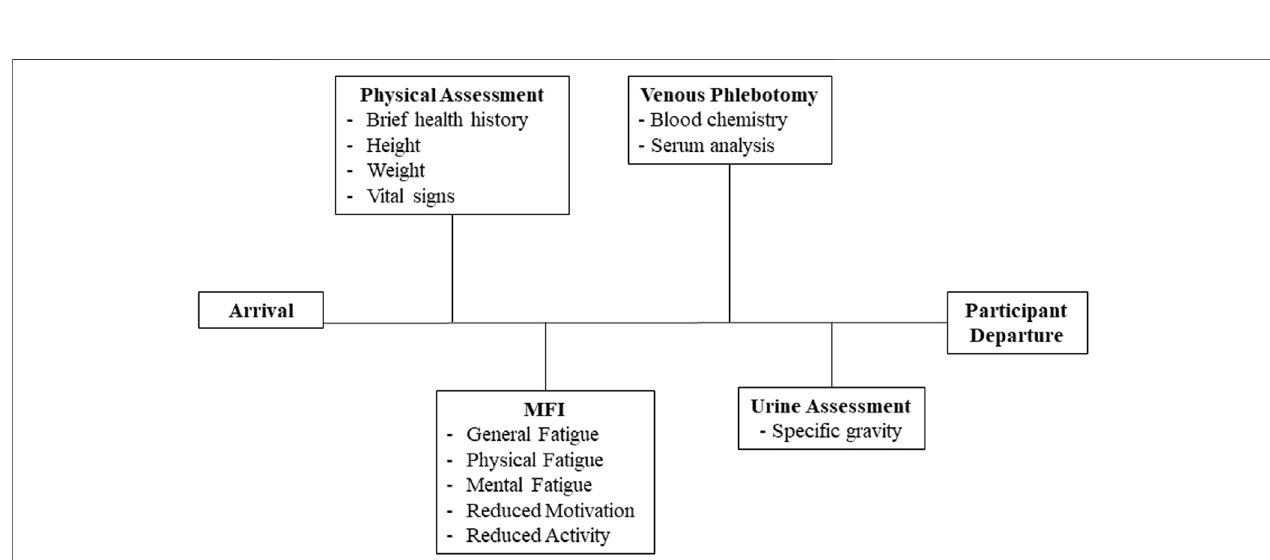
FIGURE 2 | Biologic and self-reported data. This fi gure illustrates the speci fi c biological samples and self-reported data collected during baseline (Sunday), midweek (Tuesday) and the study endpoint (Thursday) at each station. Data collection required approximately 40 min and only occurred after each participant ’ s completion of their scheduled